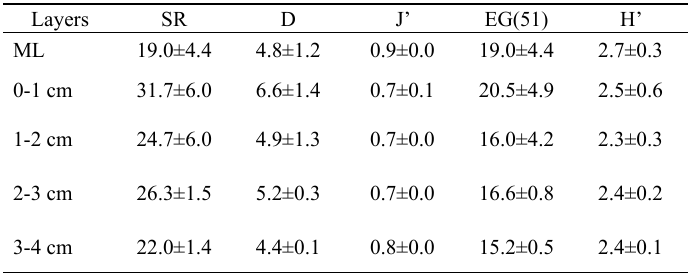
Table S4. – Nematode diversity indices in the maerl bed: species richness (SR), Margalef diversity (D), Pielou evenness (J’), expected genus number (EG(51)) and Shannon index (H’).